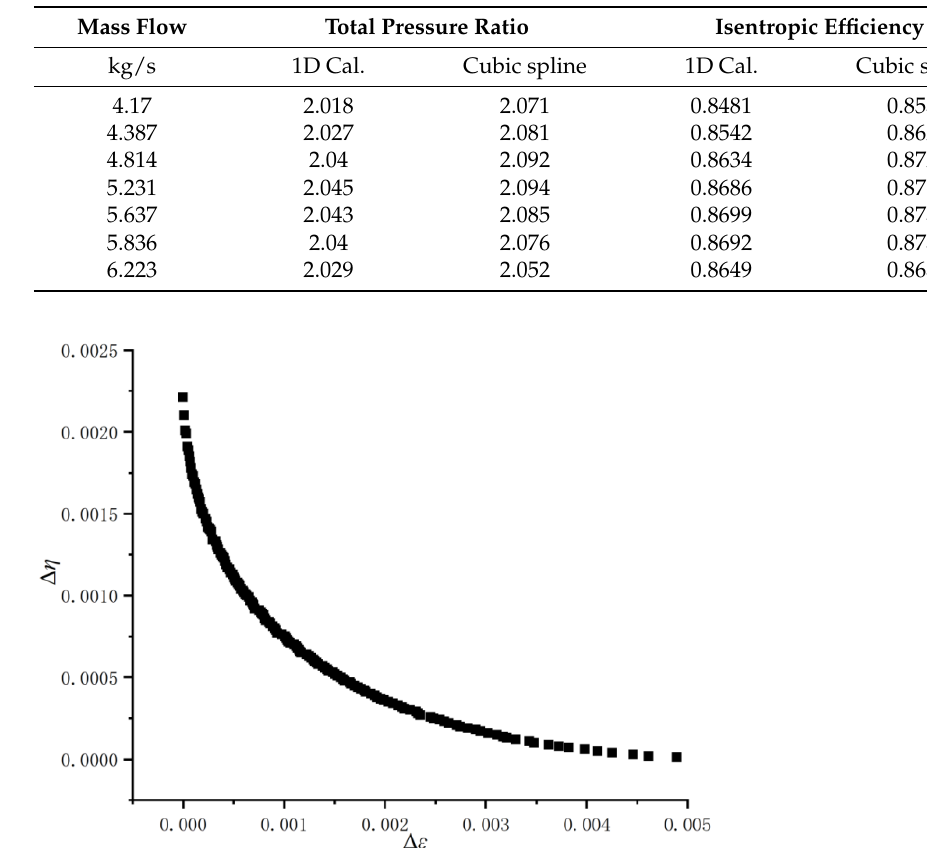
Figure 10. Pareto front for the Eckardt-O impeller.